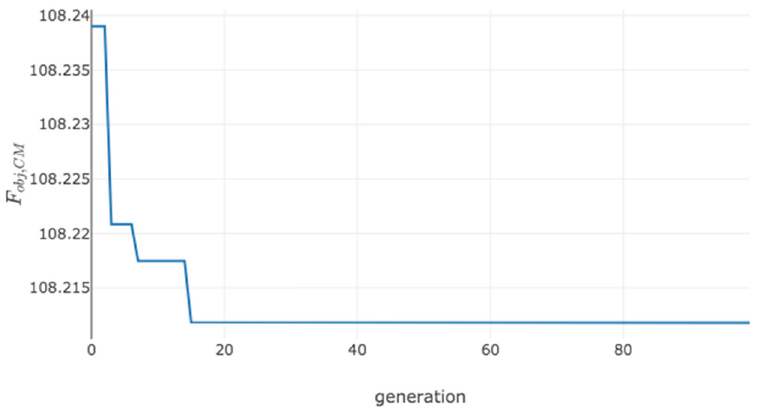
Figure 9. Evolution of the value of the objective function (4) for the best individual of each generation.